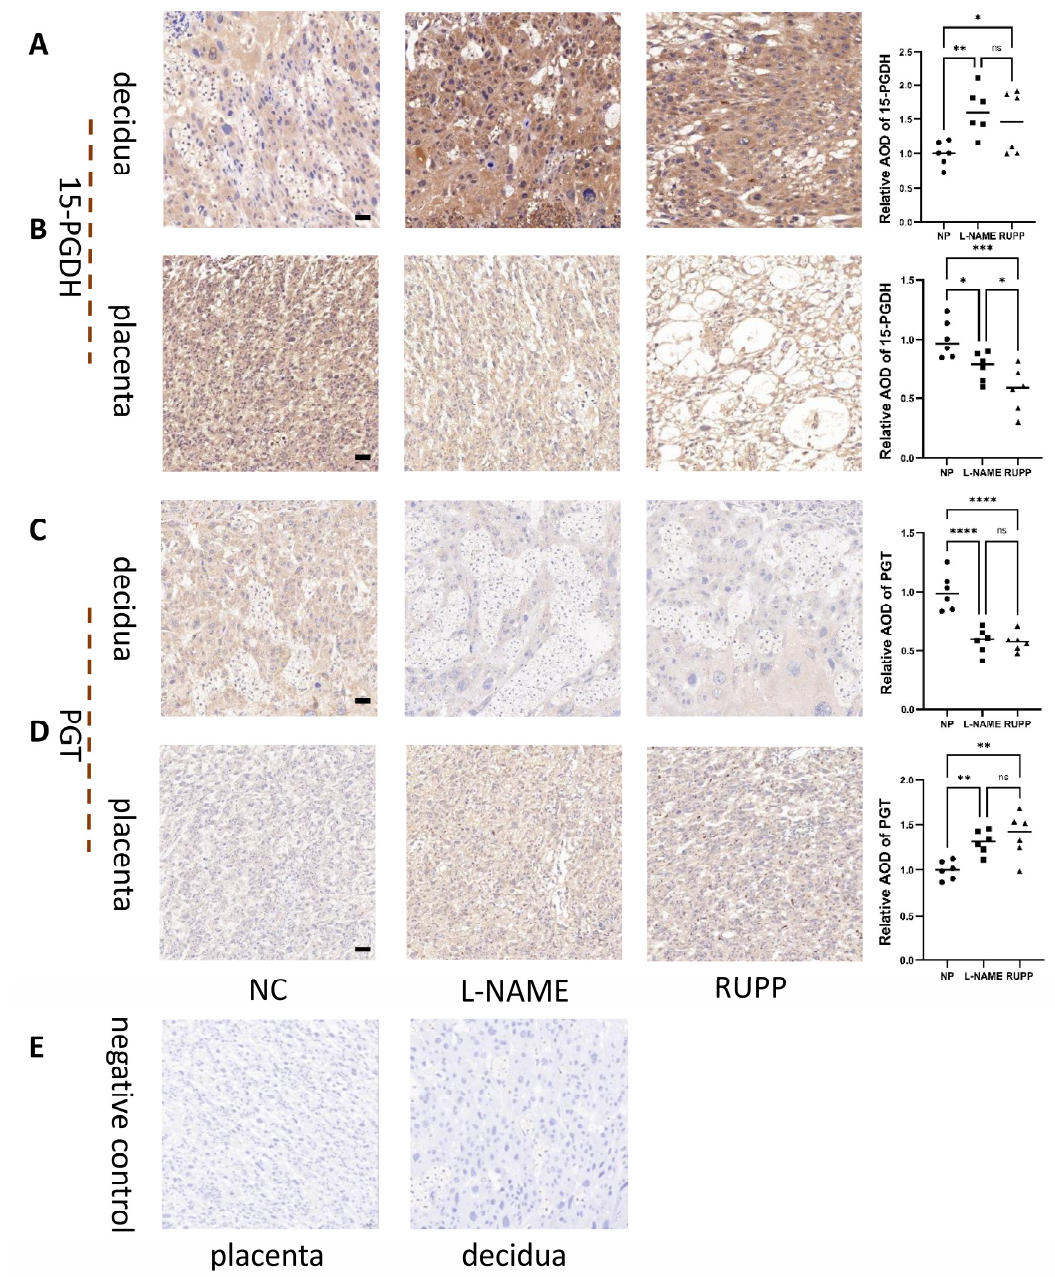
Figure 9. Enzyme 15-PGDH and PGT enzymes in the RUPP and L-NAME models. ( A ) Immunohistochemical staining showed the localization and relative quantification of 15-PGDH in the decidua of the RUPP and L-NAME rat groups. Brown staining represents the target protein, and ( B ) immunohistochemical staining showed the localization and relative quantification of 15-PGDH in the labyrinth zone of the RUPP and L-NAME vs. NP rat groups. n = 6 for each group. ( C ) Immunohistochemical staining showed the localization and relative quantification of PGT in the decidua of the RUPP and L-NAME rat groups. Brown staining represents the target protein, and ( D ) immunohistochemical staining showed the localization and relative quantification of PGT in the labyrinth zone of the RUPP and L-NAME vs. NP rat groups. The results are representative of at least three independent experiments. ( E ) represents negative control of placenta and decidua. Scale bar = 50 nm. * p < 0.05; ** p < 0.01; *** p < 0.001; **** p < 0.0001; ns, not significant (one-way ANOVA). n = 6 for each group. NP: normal pregnancy.